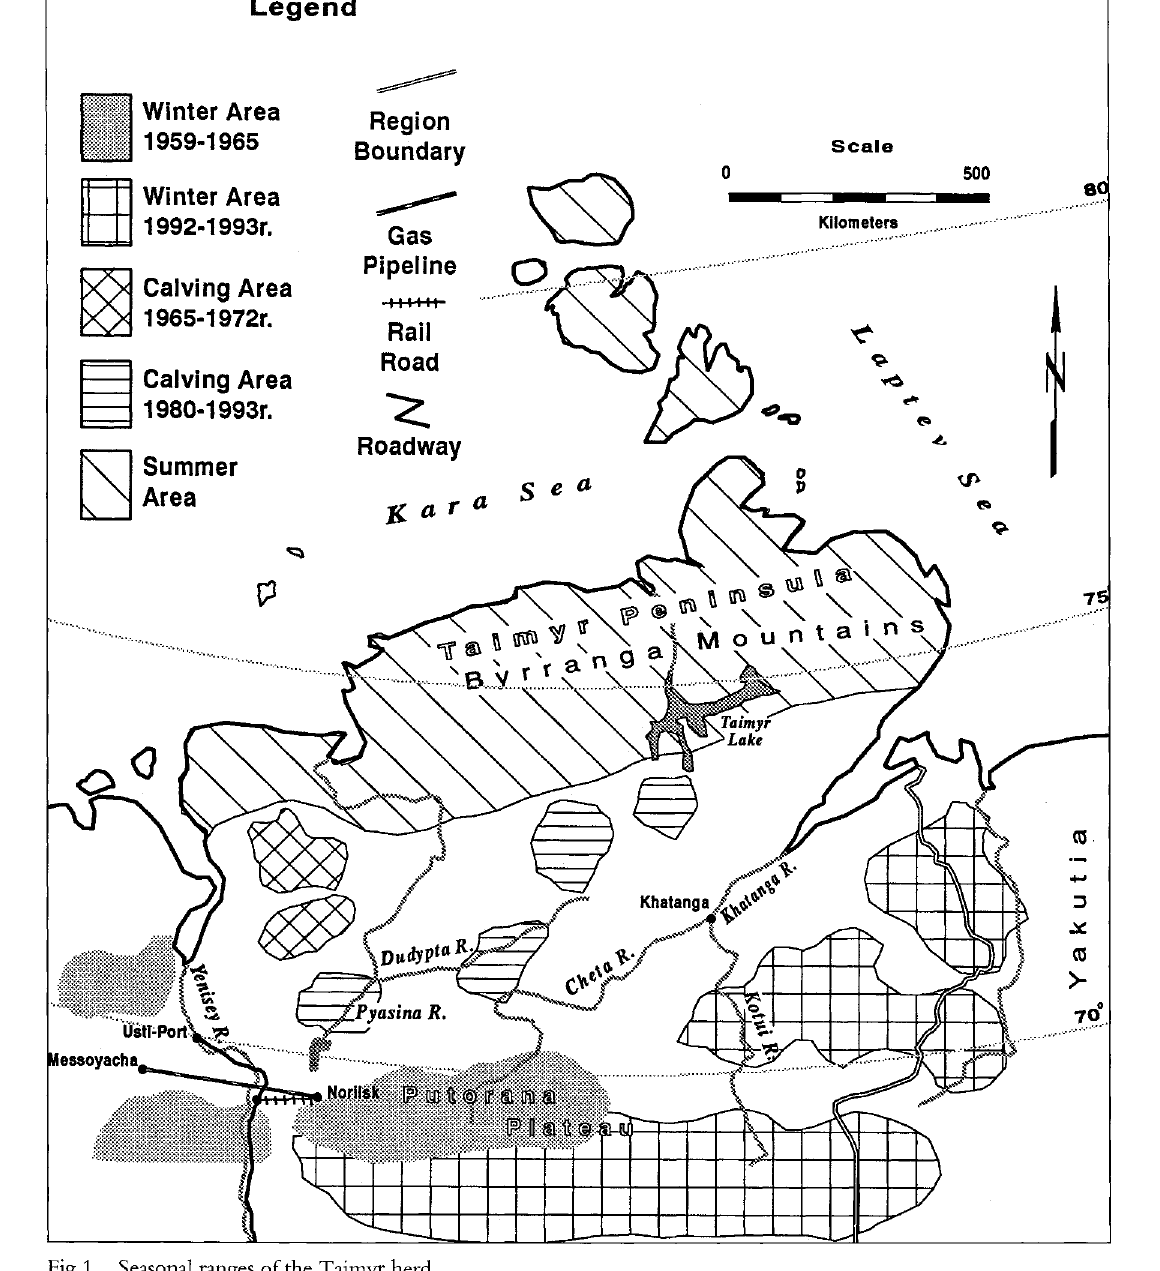
Fig 1. Seasonal ranges of the Taimyr